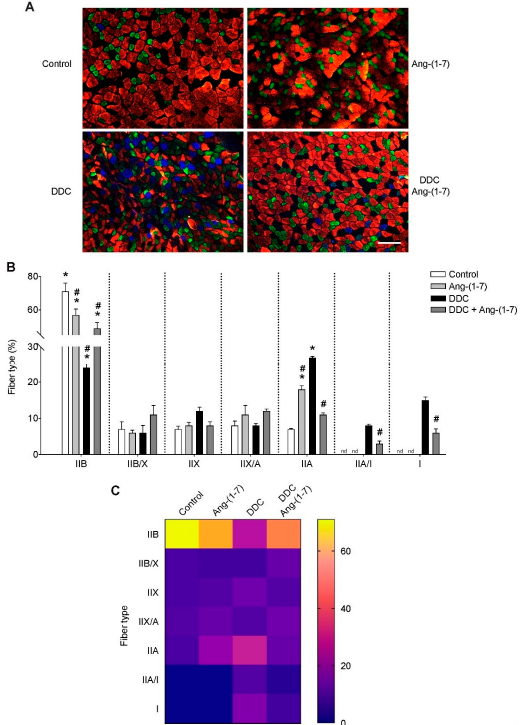
Figure 4. Ang-(1-7) prevents the fiber type transitions in gastrocnemius muscle from mice fed with the DDC diet. Male mice C57BL/6J (16 weeks old) were randomly separated into four groups: Control,